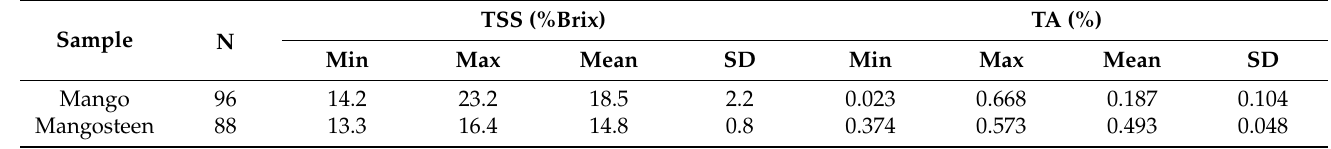
Table 2. Statistical parameters of the mango and mangosteen pur é e used for model